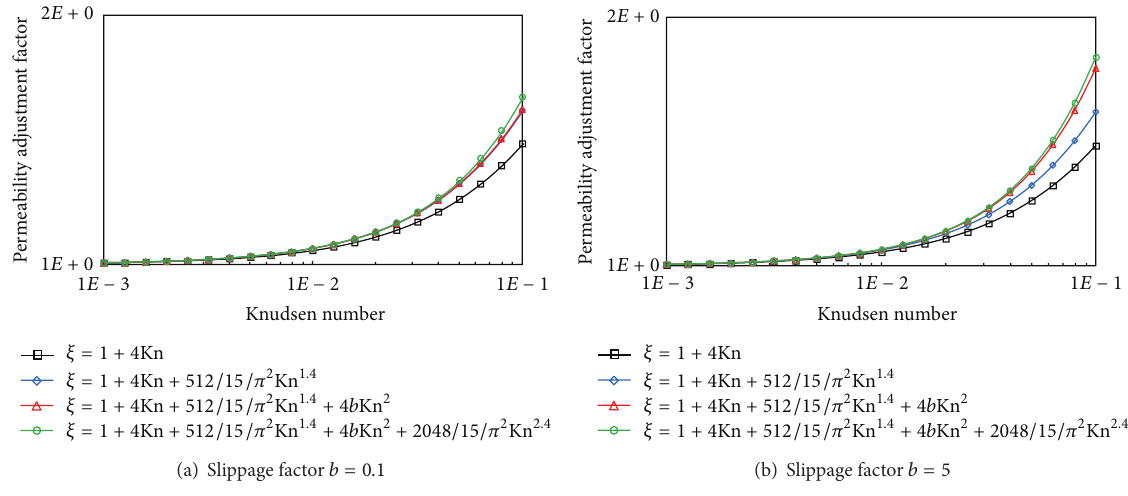
Figure 2: Relationship between permeability correction factor and Knudsen